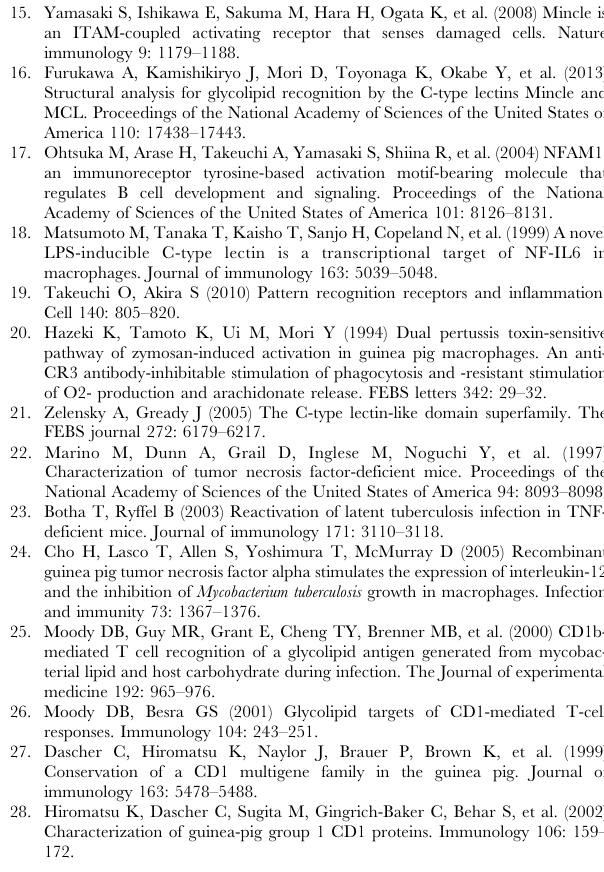
Figure 7. Characterization of gpMCL. (A) Immunoblot of gpMCL. HEK293T cells were transfected with HA-tagged mMCL or gpMCL. Total lysates were blotted with anti-HA mAb (left panel) or immunoprecipitated with anti-HA pAb and blotted with anti-HA mAb (right panel). (B) gpMCL is associated with gpFcR c . HEK293T cells were transfected with HA-tagged gpMCL alone or together with Flag-tagged gpFcR c Total lysates were immunoprecipitated with anti-HA pAb and blotted with anti-Flag pAb and anti-HA mAb. Total lysates were also blotted with anti-Flag pAb. (C) Surface expression of gpMCL. HEK293T cells were transfected with HA-tagged gpMCL alone or together with gpFcR c -IRES-GFP. HEK293T cells were also transfected with HA-tagged mMCL together with mFcR c -IRES-GFP. Surface expression of gpMCL or mMCL was detected by anti-HA pAb. (D) gpMCL fails to recognize TDM. Indicated reporter cells were stimulated with plate-coated TDM for 24 h. Induction of NFAT-GFP was analyzed by flow cytometry. Data are presented as mean 6 s.d. (D) and representative of two or three separate